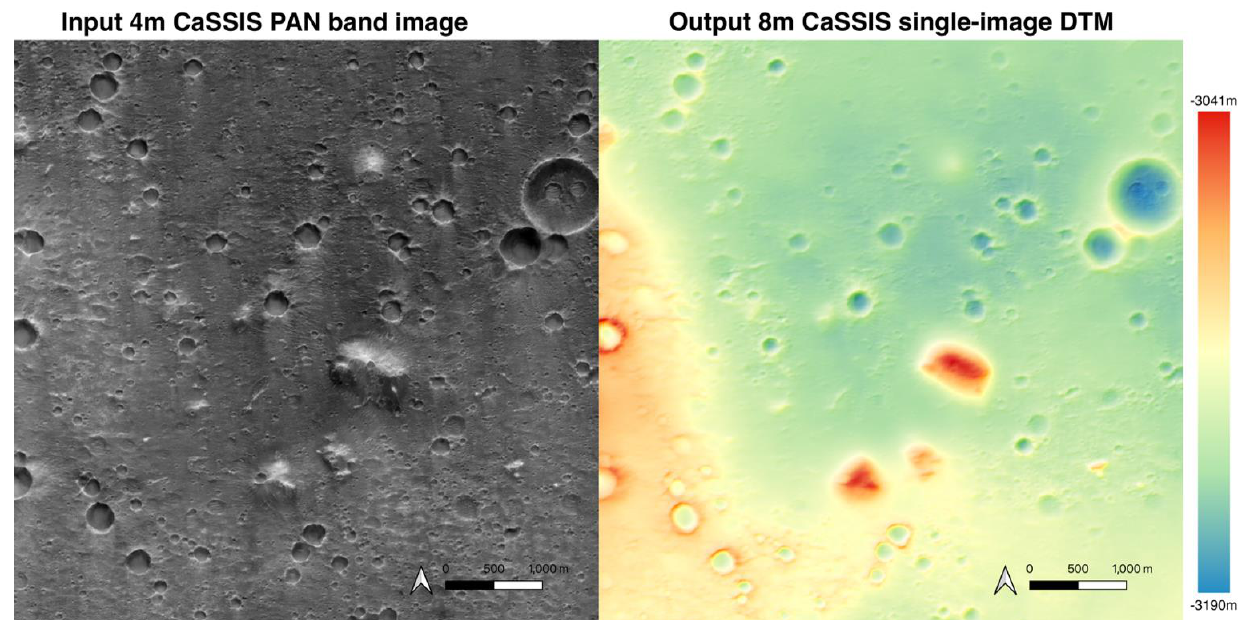
Figure 1. An example of the input 4 m/pixel CaSSIS panchromatic band image (MY35_007623_019_0_PAN) and the output 8 m/pixel CaSSIS DTM (colour hillshaded) produced in near-real-time using the proposed MADNet single-image DTM processing system.